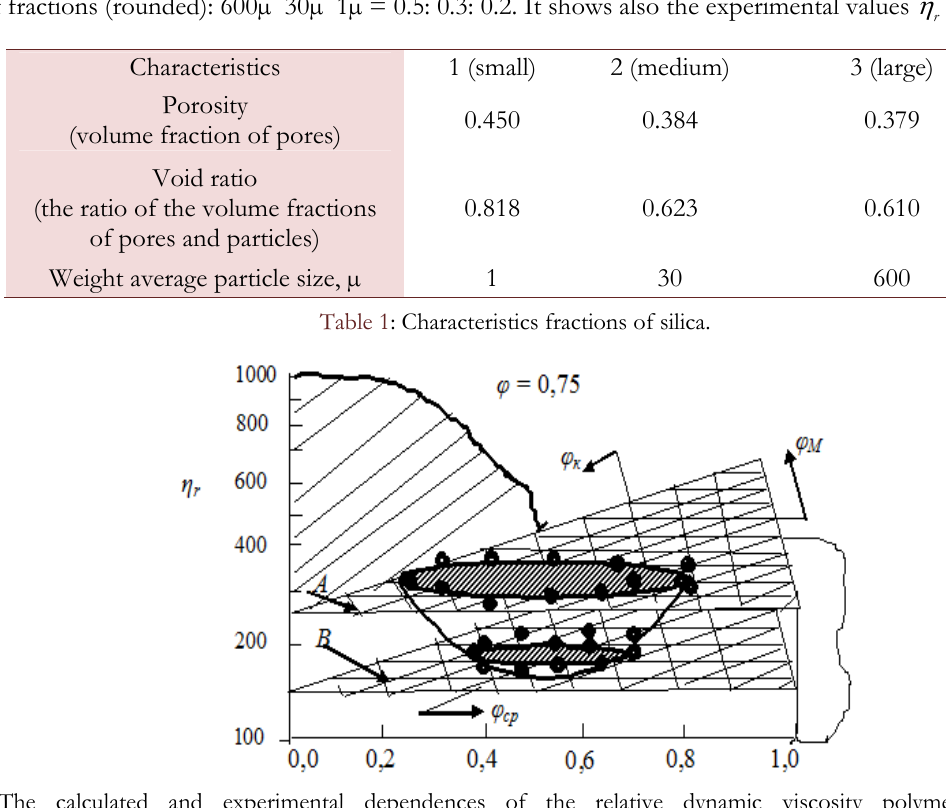
Figure 1: The calculated and experimental dependences of the relative dynamic viscosity polymer slurry based by polydinurethanepoxide (PDI-3B) and polybutadiencarboxilate (SKD-CTR) from volumetric ratios of 3 fractions of silica: A, B - levels calculated iso-viscosity, round icons - experimental data.